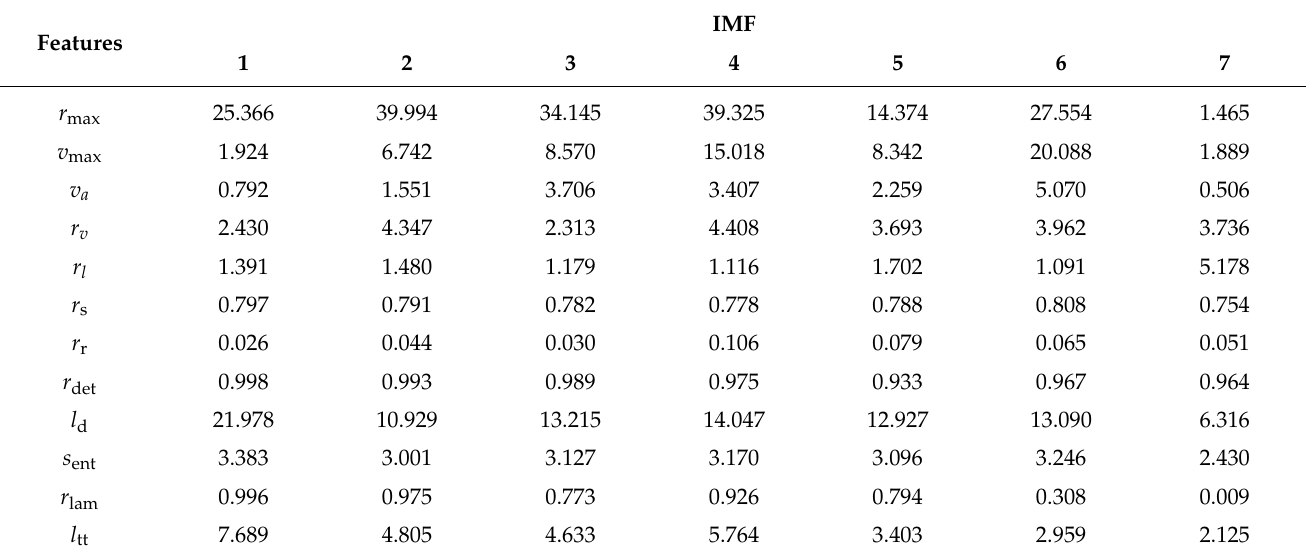
Table 3. Feature extraction results of vibration signal during the trip